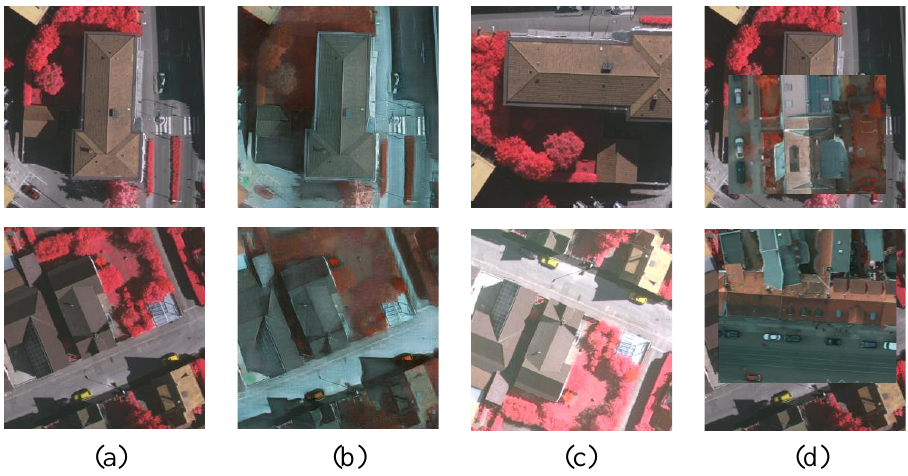
Figure 4. Transformation of images from target domain for consistency training. ( a ) Target domain images without transformation. ( b ) Source-stylized target images. ( c ) Augmented target images. ( d ) Target images mixed by source image